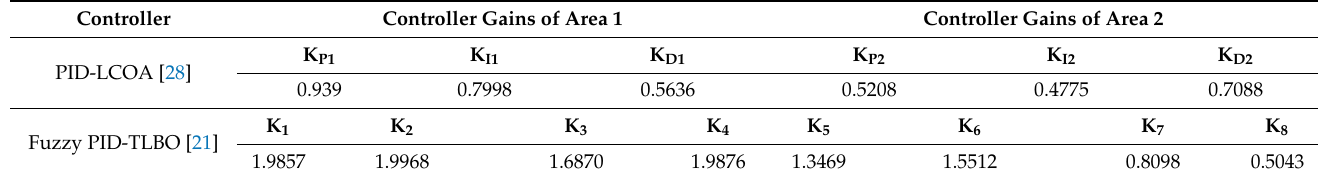
Table 5. Gains of PID controllers tuned by LCOA and Fuzzy PID controllers tuned by TLBO.